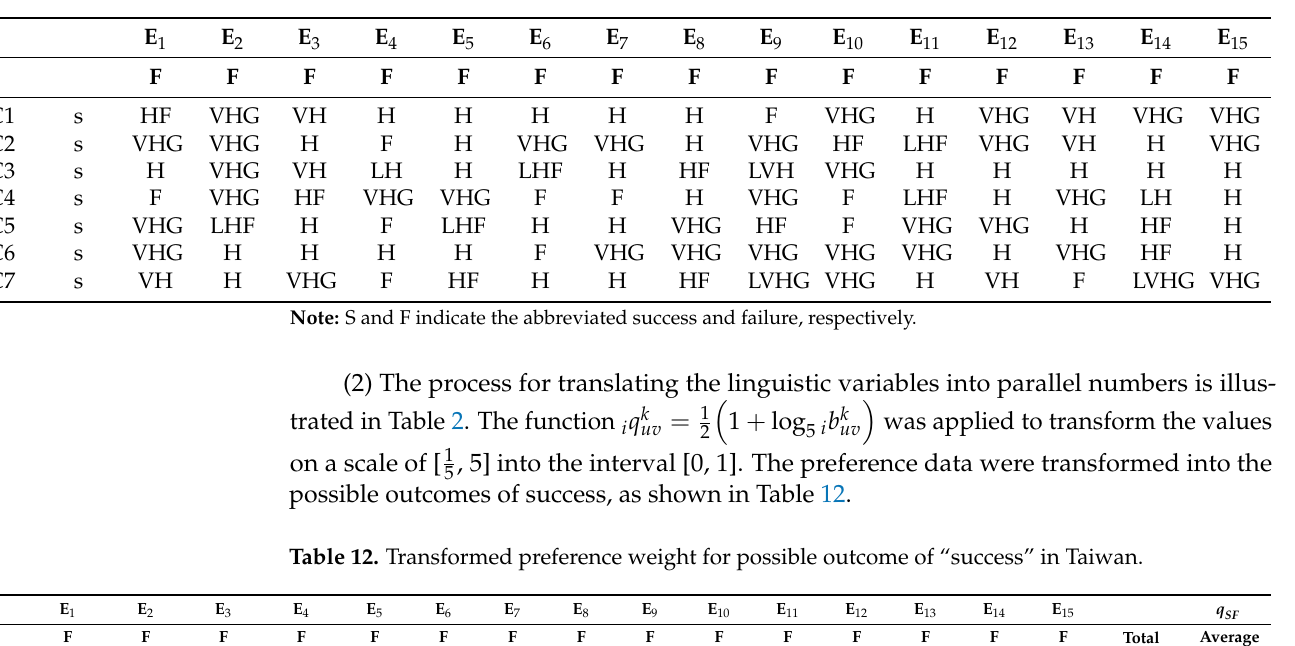
Table 11. Linguistic variables assigned to the priority weights of the two possible outcomes in Taiwan.